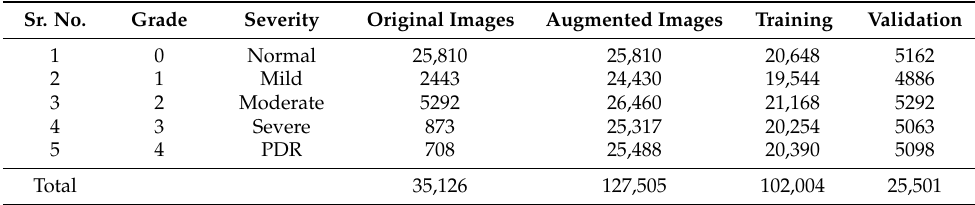
Table 7. The distribution of augmented data into training and testing data. Sr.